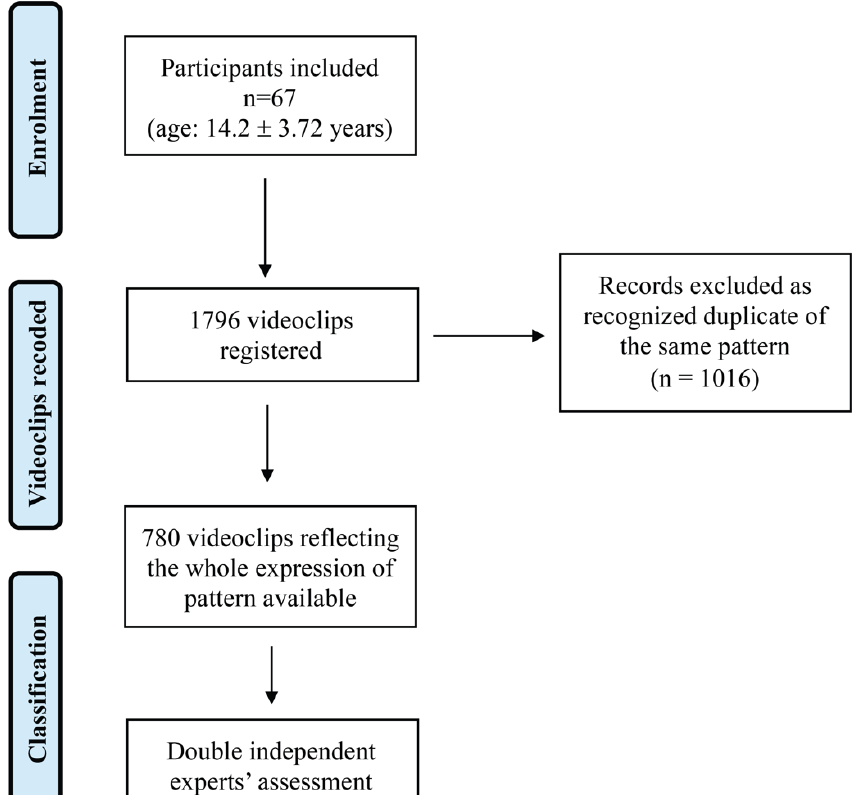
Figure 1. Flow diagram of video clips selection.